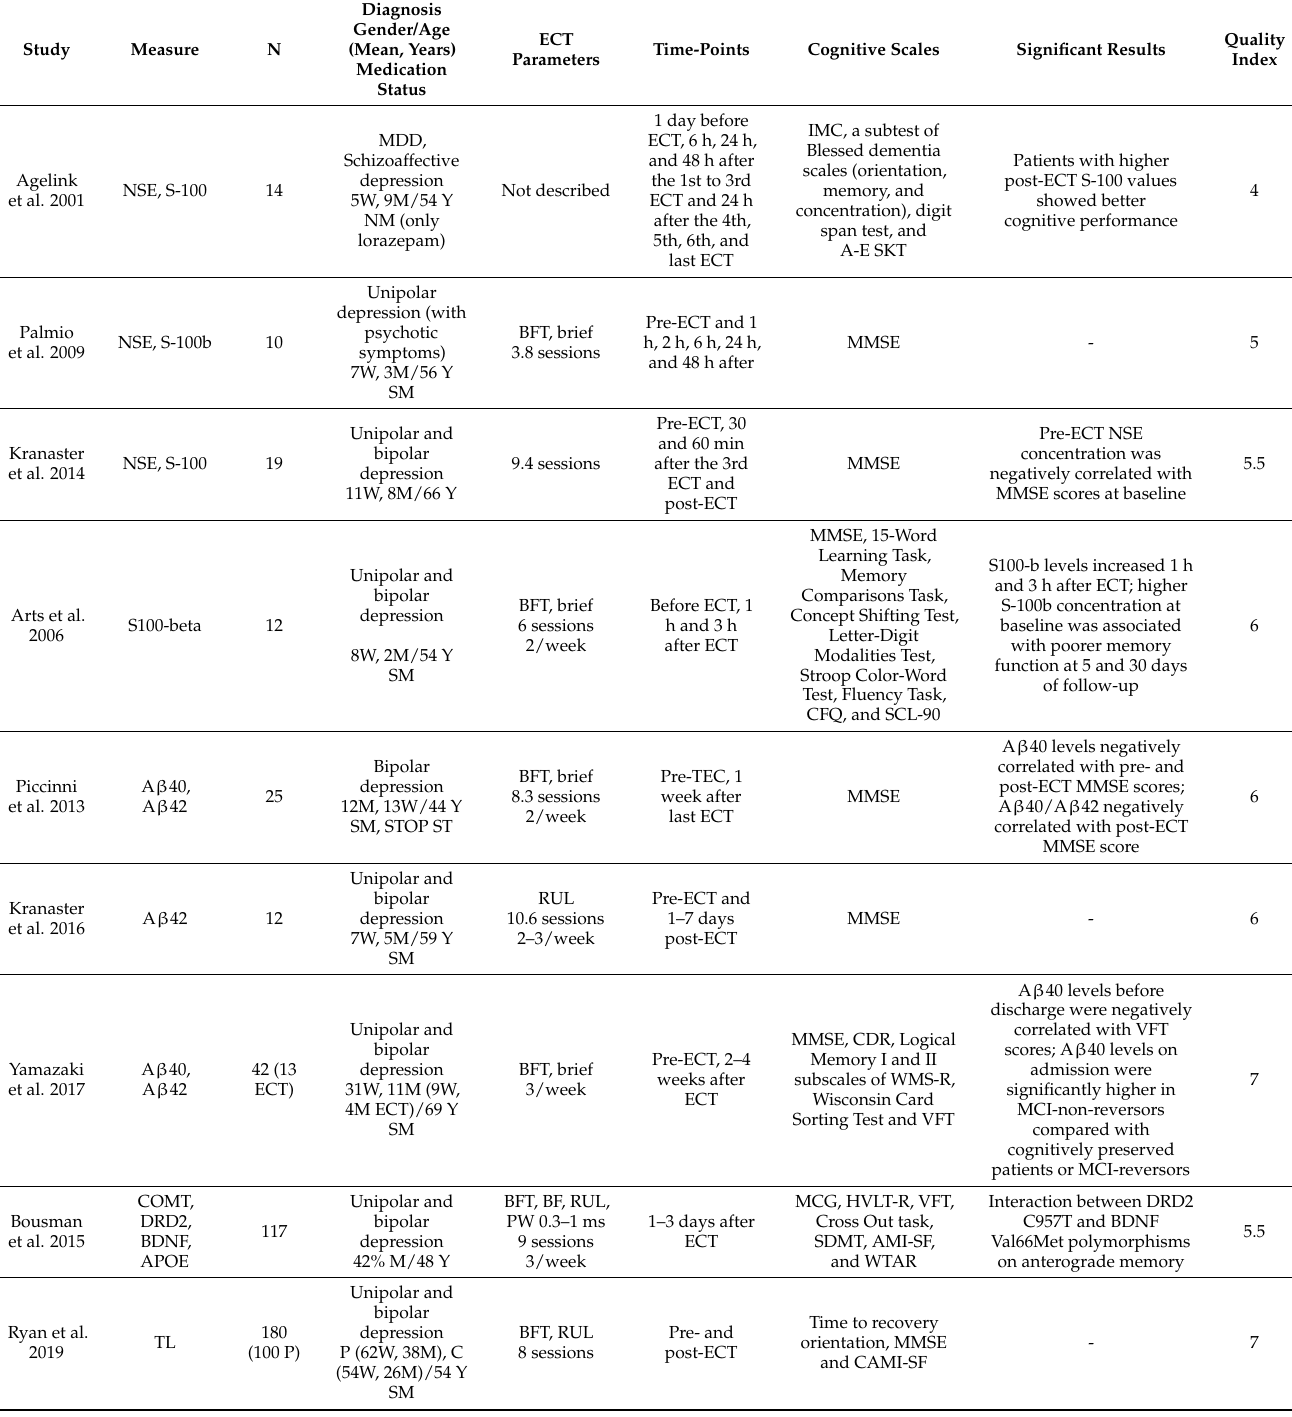
Table 1. Genetic and molecular biomarkers